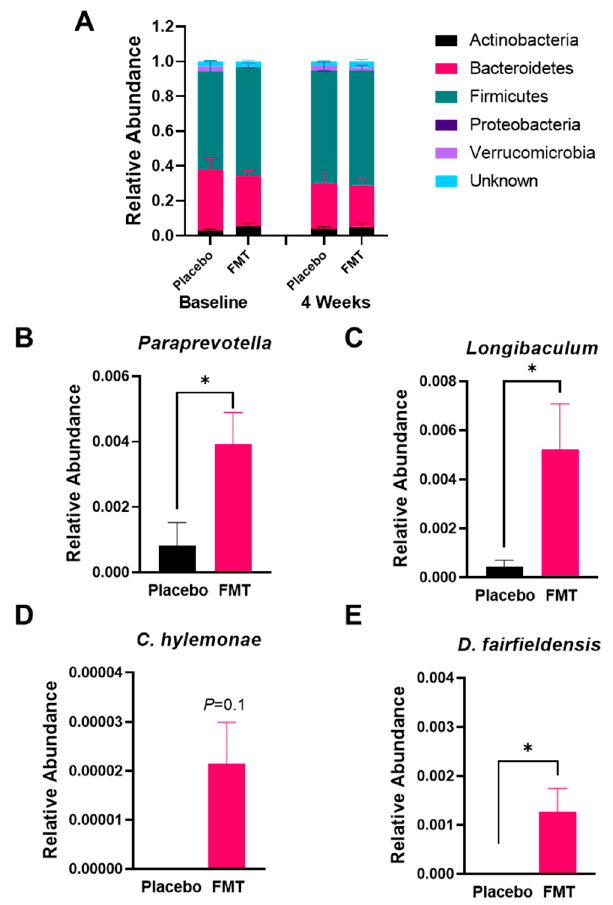
Figure 2. Impact of FMT on gut microbial composition. ( A ) Relative abundance of each bacterial phylum. Relative abundance of Paraprevotella ( B ) and Longibaculum ( C ), Clostridium hylemonae ( D ), and Desulfovibrio fairfieldensis ( E ) in fecal samples from placebo vs. FMT at baseline and after 4 weeks of treatment. Data presented as mean ± SEM. * p < 0.05 .